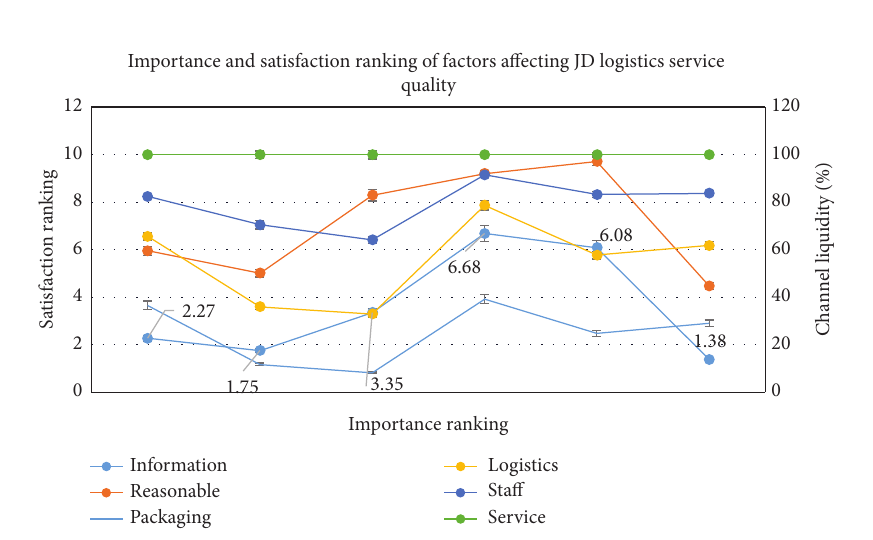
Figure 8: Importance and satisfaction ranking of factors affecting JD logistics service